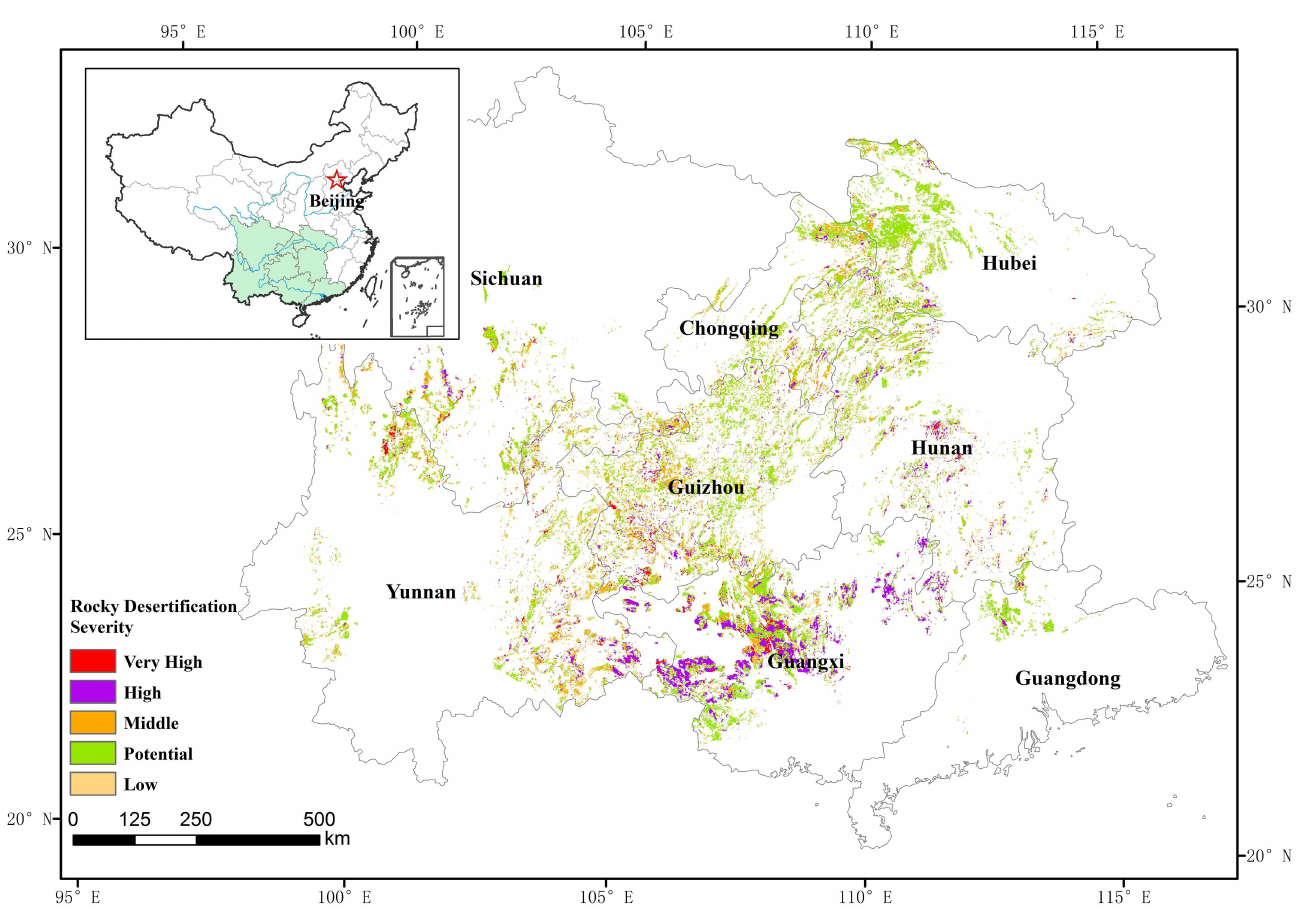
Fig 1. Spatial distribution of the different severity of the rocky desertification in the study area.